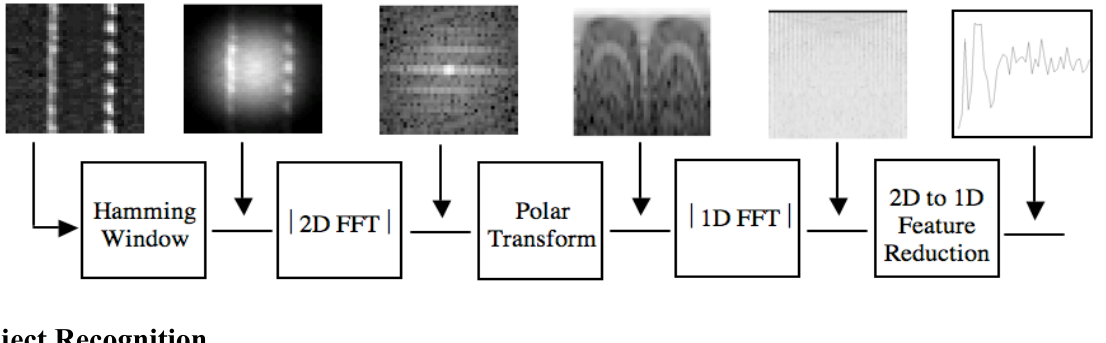
Figure 9. Basic texture analysis